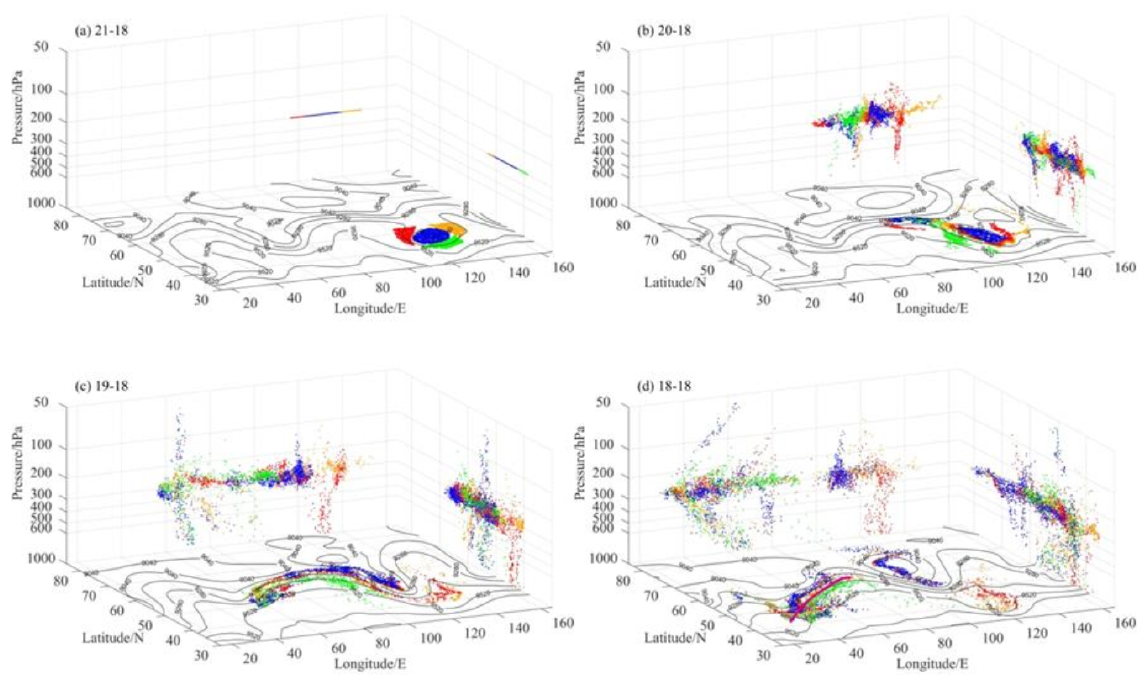
Figure 5. The initial positions of the four parts of the targeted parcels in the main body of the COL at 300 hPa ( a ). Projection of the targeted parcels on the longitude–latitude, longitude–height, and latitude–height planes at 18:00 on 20 June ( b ), at 18:00 on 19 June ( c ) and at 18:00 on 18 June ( d ). The geopotential height (black contours, unit: gpm) are additionally plotted on each longitude–latitude plane. Colored dots indicate different clusters. The superimposed pink solid line in ( d ) represents the extratropical jet stream axis.